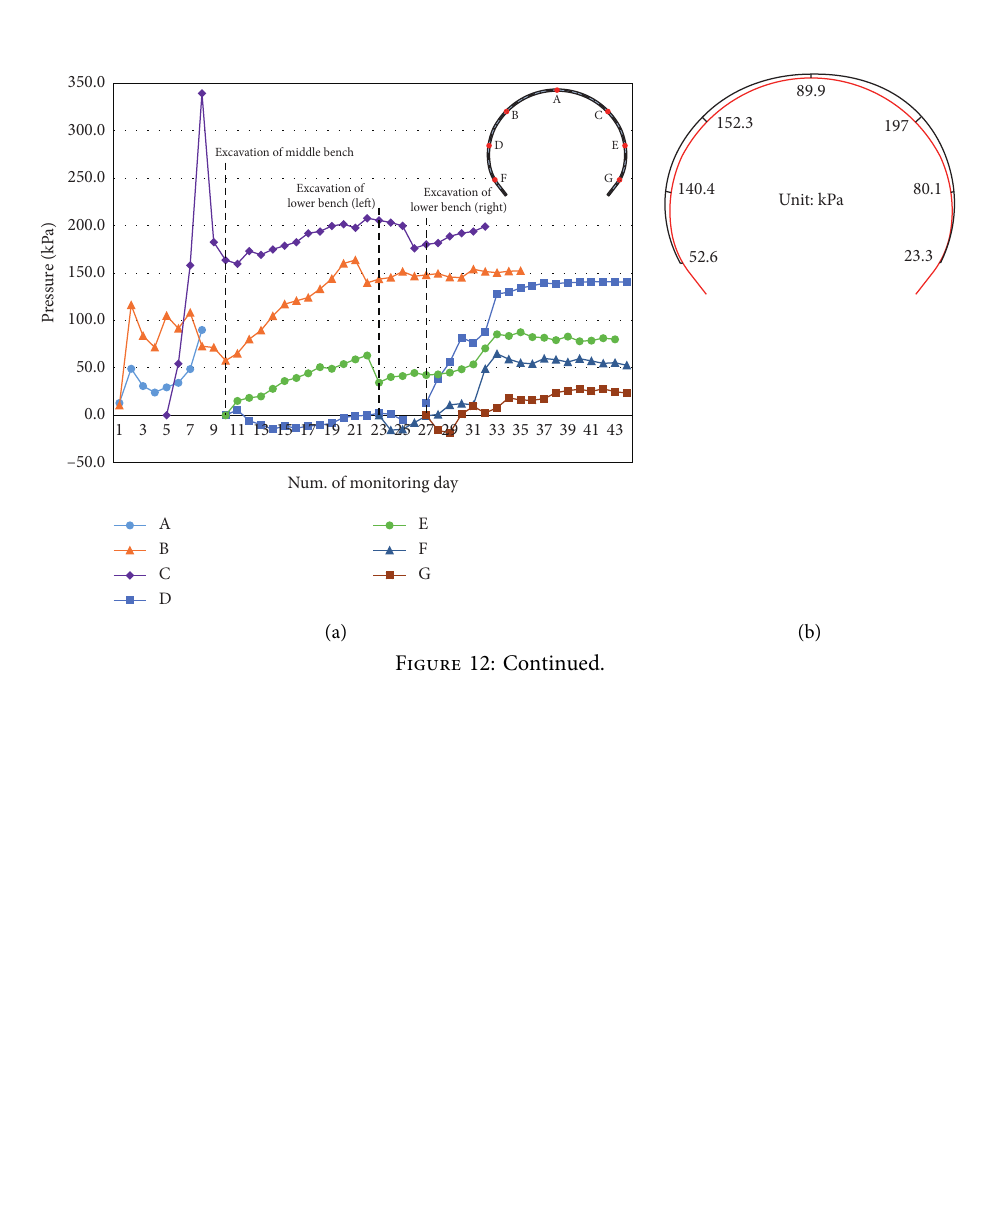
Figure 11: Spatial distribution of total displacement of the primary lining at (a) Z5K64 +500 and (b)